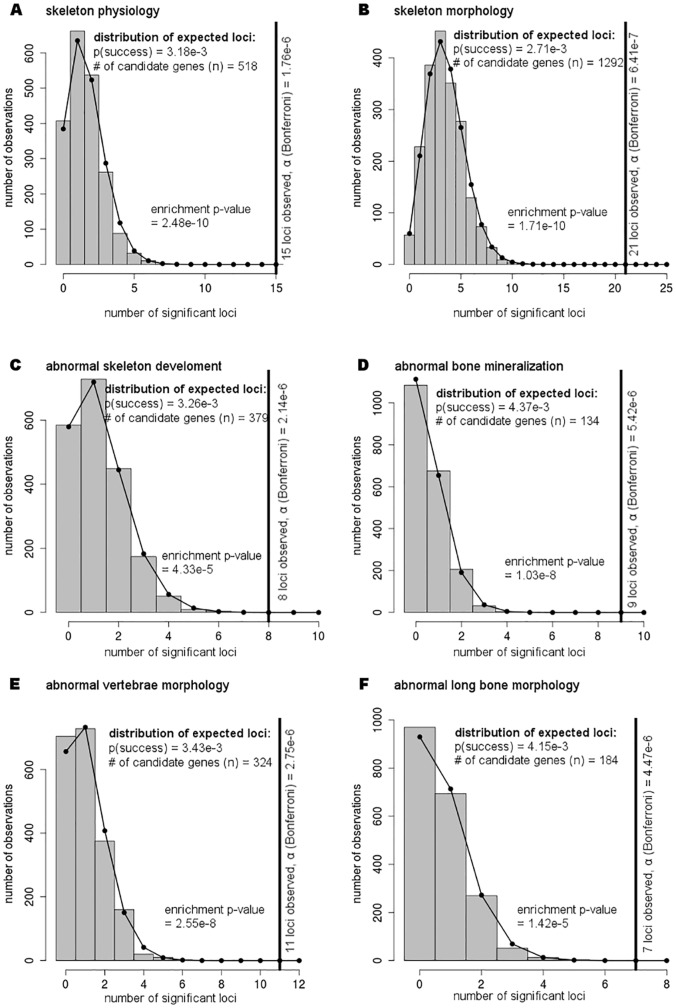
GenToS identifies significant enrichment of genes containing femoral neck bone mineral density-associated SNPs based on candidate gene input lists for murine bone phenotypes.For each of the six candidate gene input lists, the number of expected significant genes under the null hypothesis was generated based on iterations of randomly drawn gene lists that contained an equal number of genes as the respective candidate gene input list and is displayed as a histogram. In addition, the binomial density distribution corresponding to the candidate gene input list significance threshold was overlaid (dots connected with lines). The observed number of significant genes based on the use of GenTos with the candidate gene input lists and the human GWAS results for femoral neck bone mineral density is indicated by a vertical black line. The enrichment p-value is computed from the complementary cumulative binomial distribution (see Methods).